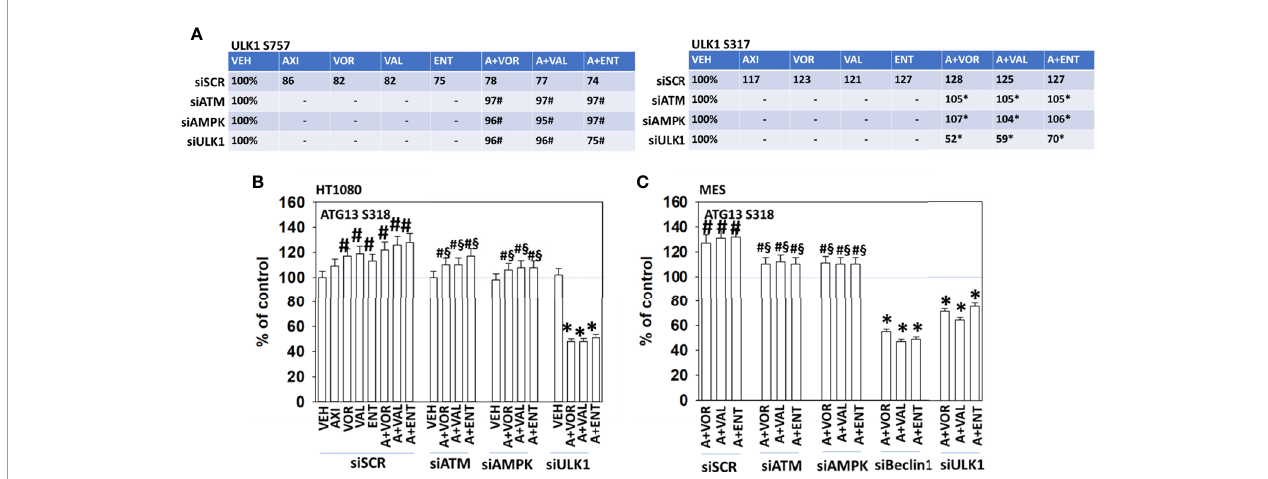
FIGURE 4 | Alterations in ULK1 phosphorylation require ATM-AMPK signaling; autophagy is required for cell killing. (A) HT1080 cells were transfected with a scrambled control siRNA (siSCR) or with validated siRNA molecules to knock down the expression of either ATM or AMPK a . Twenty-four h after transfection, cells were treated with vehicle control, axitinib (50 nM), entinostat (50 nM), vorinostat (500 nM), sodium valproate (250 m M) alone or in combination as indicated in the graphical panels for 6h. Cells were fi xed in place and in-cell immunoblotting performed to determine the total protein levels of ULK1 and the phosphorylation of ULK1 S317 and ULK1 S757. The percentage phosphorylation is stated for each site corrected for total protein loading with vehicle control of each transfection being de fi ned as 100% (n = 3 +/-SD). # p < 0.05 greater than vehicle control; *p < 0.05 less than vehicle control. (B, C) HT1080 and MES cells were transfected with a scrambled control siRNA (siSCR) or with validated siRNA molecules to knock down the expression of either ATM or AMPK a . Twenty-four h after transfection, cells were treated with vehicle control, axitinib (50 nM), entinostat (50 nM), vorinostat (500 nM), sodium valproate (250 m M) alone or in combination as indicated in the graphical panels for 6h. Cells were fi xed in place and in-cell immunoblotting performed to determine the total protein levels of ATG13 and the phosphorylation of ATG13 S318. The percentage phosphorylation is plotted for ATG13 S318, corrected for total ATG13 protein loading with vehicle control of each transfection being de fi ned as 100% (n = 3 +/-SD). # p < 0.05 greater than vehicle control; § p < 0.05 less than corresponding value in siSCR cells; *p < 0.05 less than vehicle